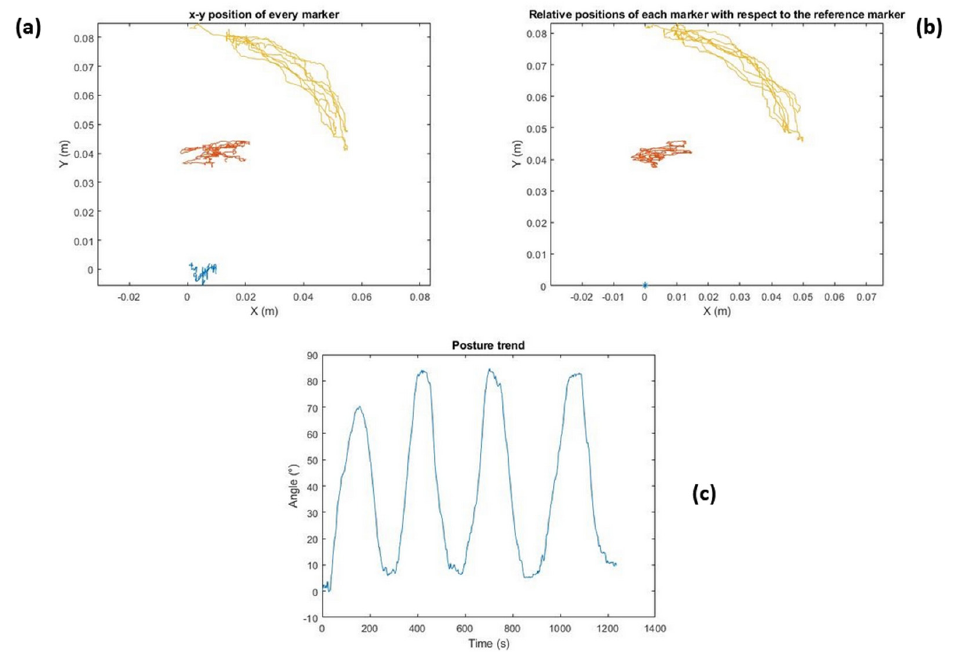
Figure 6. ( a ) X − Y position of each marker. ( b ) Relative position of marker B and C, considering marker A as reference. ( c ) Time dependence of the angle α formed by the marker B and the C